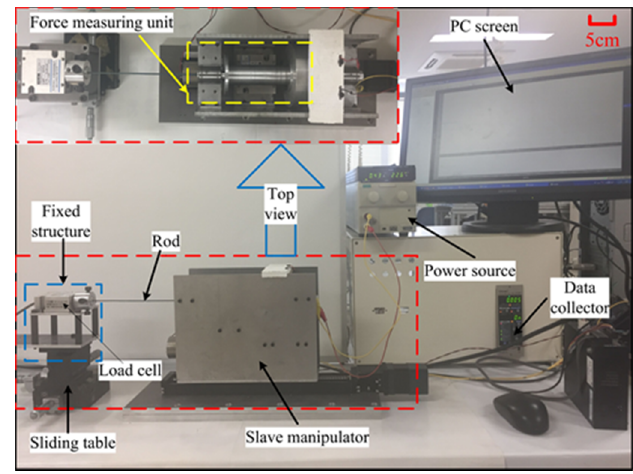
Figure 13. The experimental setup for evaluating the static characteristic.